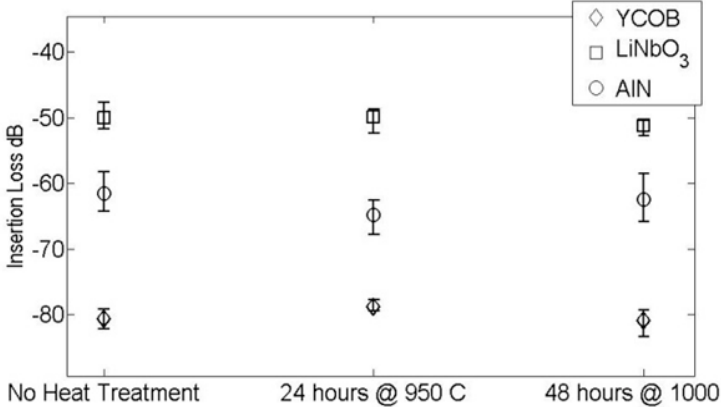
Figure 4. Comparison of heat treatment results for lithium niobate (LiNbO 3 ) , aluminum nitride (AlN), and YCOB [YCa 4 O(BO 3 ) 3 ] [3].